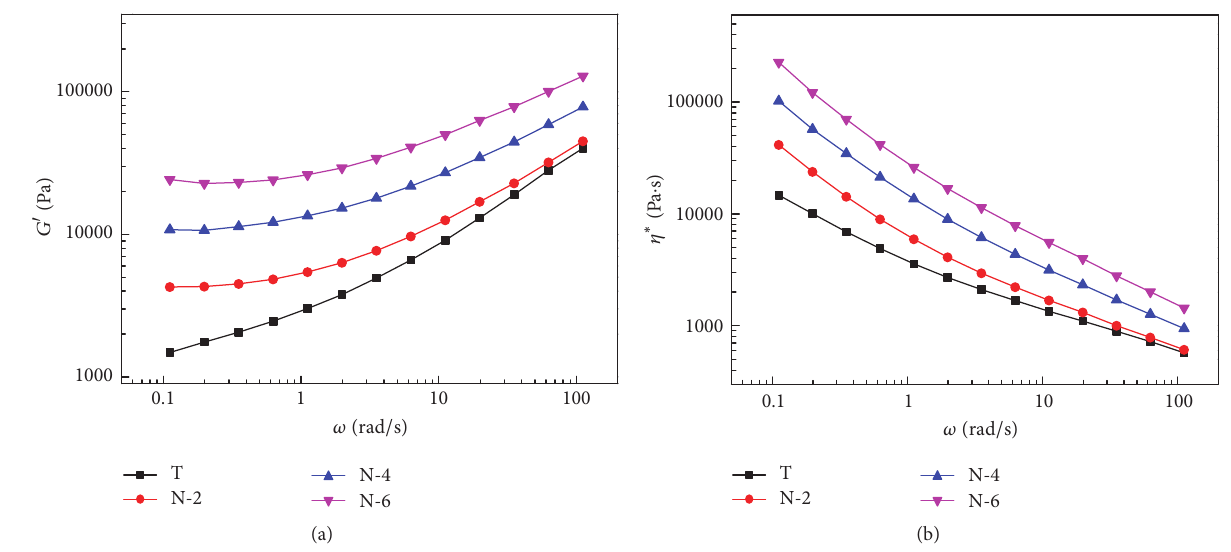
Figure 10: (a) Storage modulus ( 𝐺 󸀠 ) and (b) complex viscosity ( 𝜂 ∗ ) patterns of PPO/PA66 blends and nanocomposites.